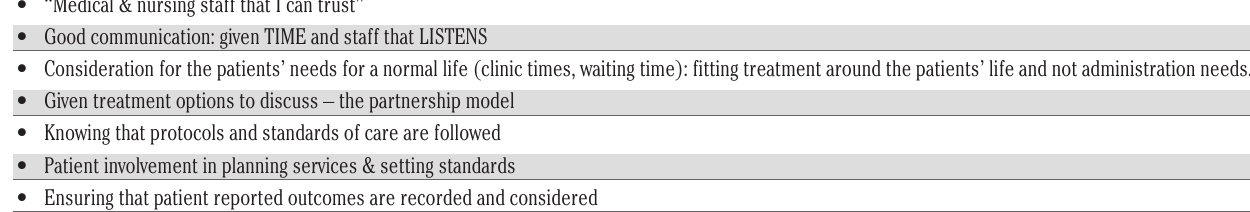
Table 1. Patient comments on services that they